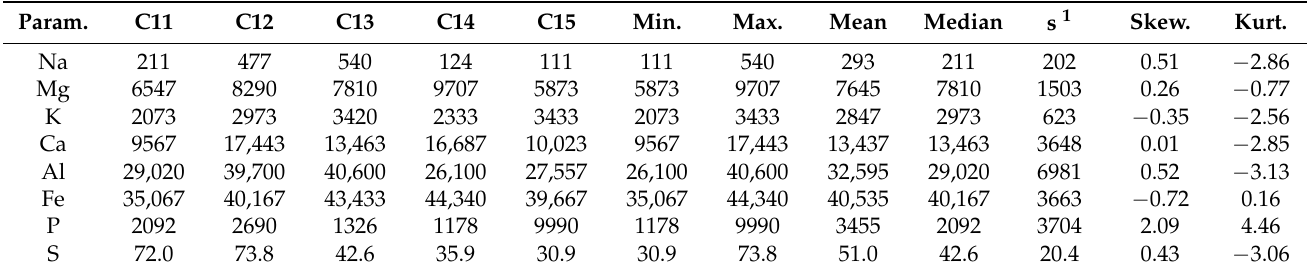
Table 4. Concentrations of the elements (mg kg − 1 ) in the silty soil samples collected from the C1 sampling point and the summary statistics.